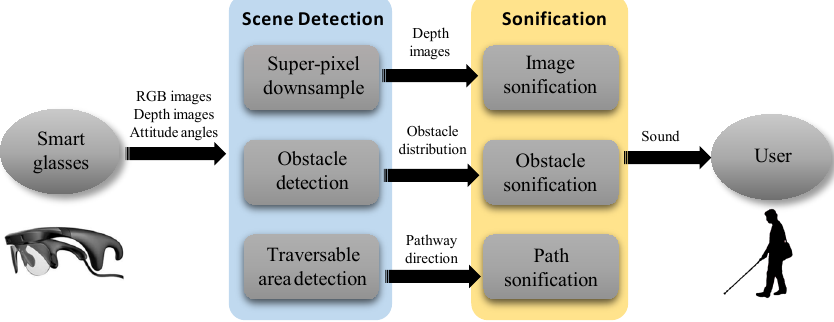
Figure 1. Flow chart of the proposed assistance system. We propose three sonification methods and corresponding scene detection algorithms to convert scene information to